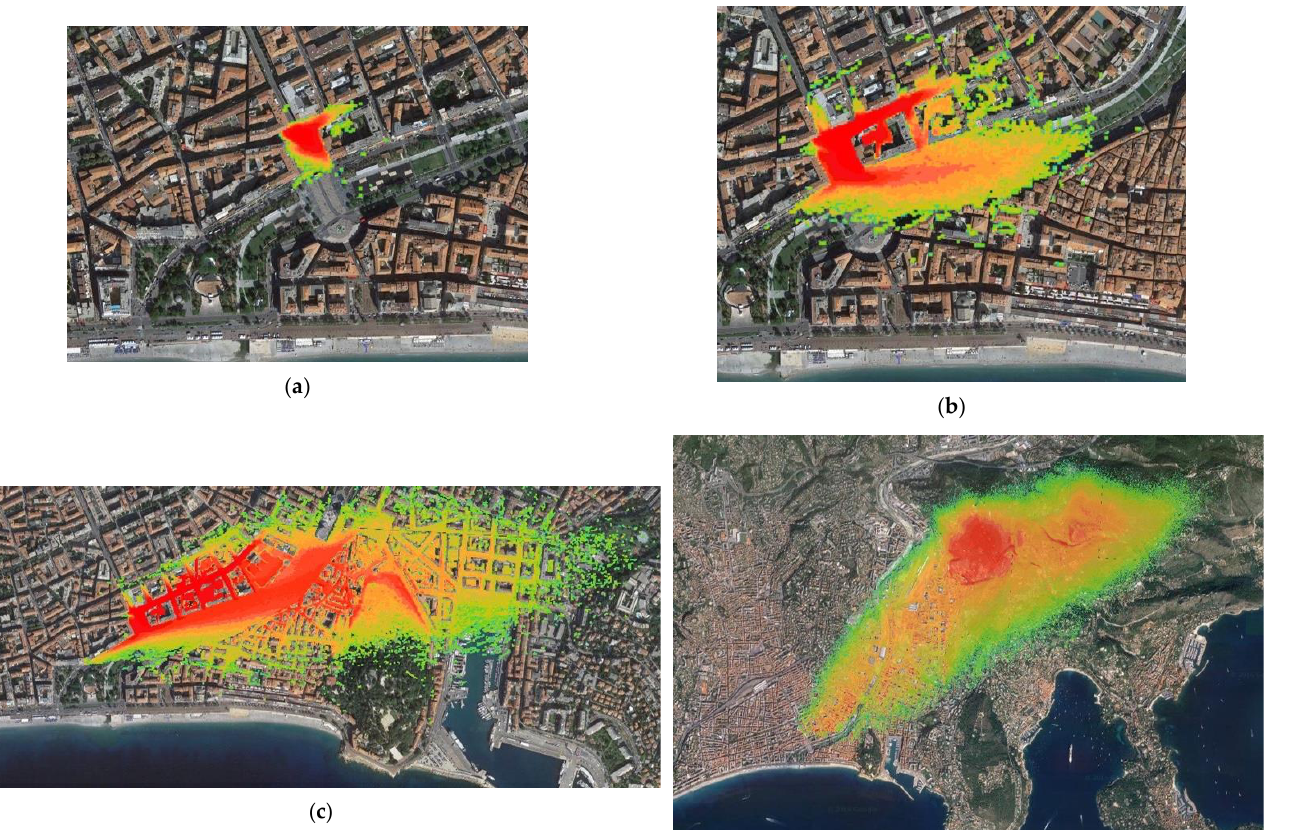
Figure 9. View, for the EMED project and the release in the Nice domain, of the plume in the vicinity and further away from the release: ( a ) 2 min after the release; ( b ) 5 min; ( c ) 15 min; ( d ) 55 min. The scale, and the zoom level, vary between the views to cope with the evolution of the plume. The threshold for 500 µg/m 3 of concentration is in red, while that for 1 µg/m 3 is in orange and that for 0.01 µg/m 3 is in green. North is at the top.